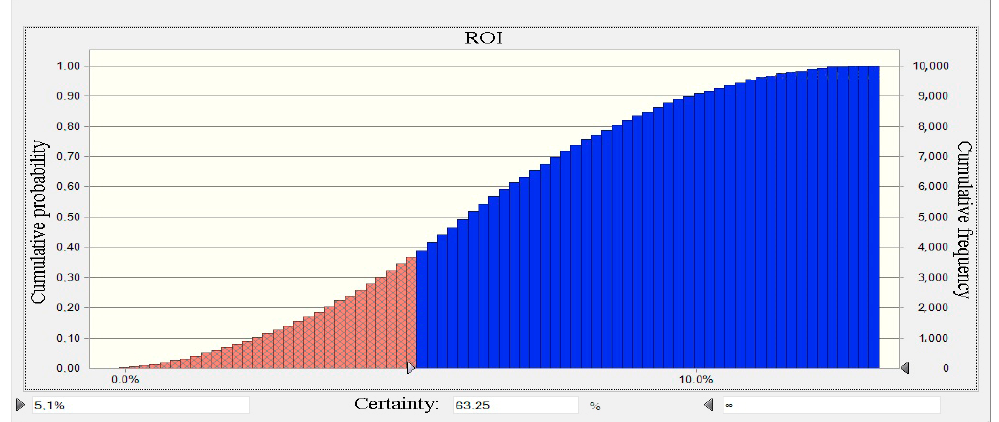
Figure 5. Cumulative probability distribution of ROI if critical levels (urban planning, technical, and administrative) are assumed for multi-family buildings after the introduction of CILAS (own elaboration).